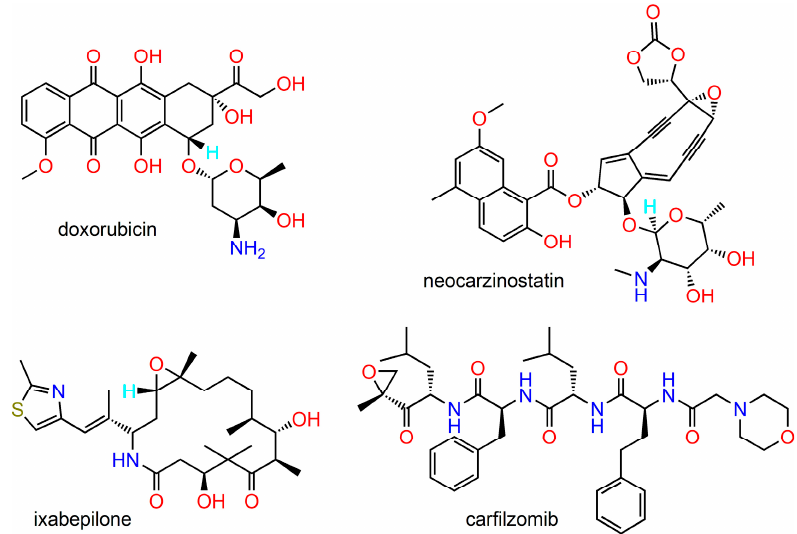
Figure 2. Representatives of antitumour antibiotics.